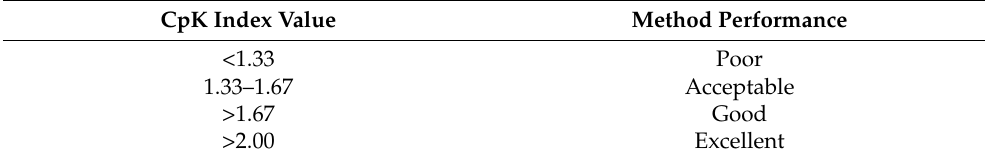
Table 2. CPK index reference value.